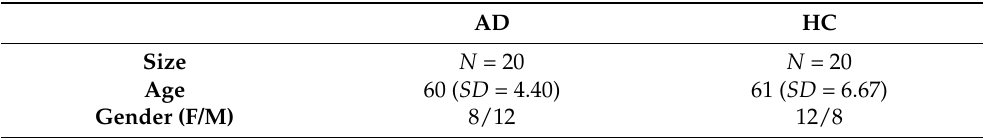
Table 1. General information of the AD and HC groups including sample size, age mean with standard deviation, and gender ratio per